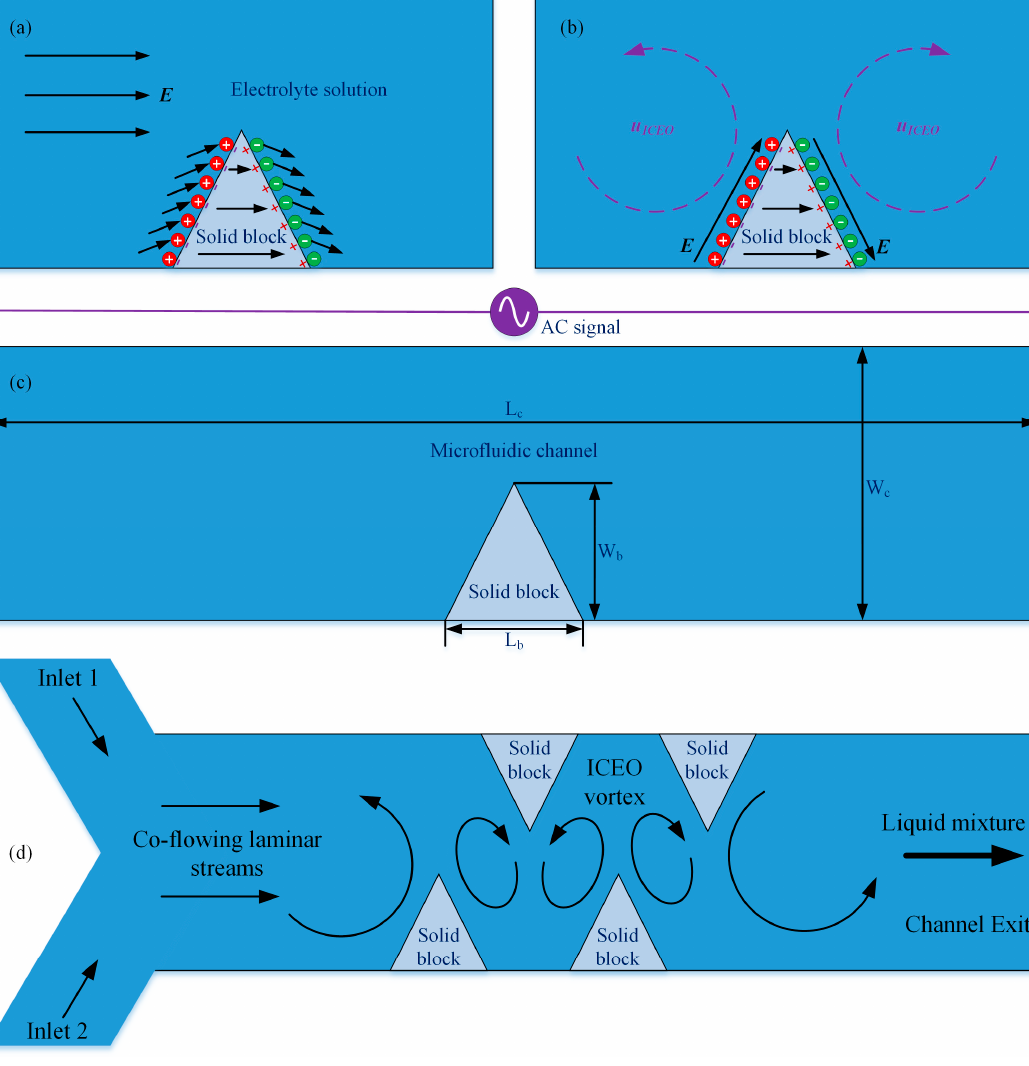
Figure 1. Schematic diagram of induced-charge electroosmotic (ICEO) next to triangular-shaped leaky dielectric block of a sharp tip with finite radius of curvature and its application to sample mixing in microfluidics. ( a , b ), Development of ICEO near a semiconductor obstruction of finite electrical conductivity and dielectric permittivity immersed in electrolyte solution, ( a ) at the early time, since the double-layer capacitance is in series connection with the leaky dielectric obstacle, Ohmic current from the bulk fluid charges both items at the same time, resulting in inclined electric field lines with respect to the solid surface that inject counterions into the Debye screening cloud; ( b ) after a characteristic double-layer relaxation time, Debye screening reaches the steady state, and no normal currents are allowed to flow into the thin boundary layer any longer, so that the electric field lines bend across the solid protrusion and forces the counterionic charges into induced-charge electroosmotic (ICEO) flow by exerting Coulomb force within the Debye layer; ( c ) Geometrical configuration of microfluidic channel embedded with leaky dielectric blocks for investigating ICEO near semiconductor protrusions; and, ( d ) An integrated design of electroosmosis micromixer taking advantage of the strong ICEO whirlpools induced adjacent to a series of sharp corners of leaky dielectric obstructions with staggered arrangement on opposing channel sidewalls.